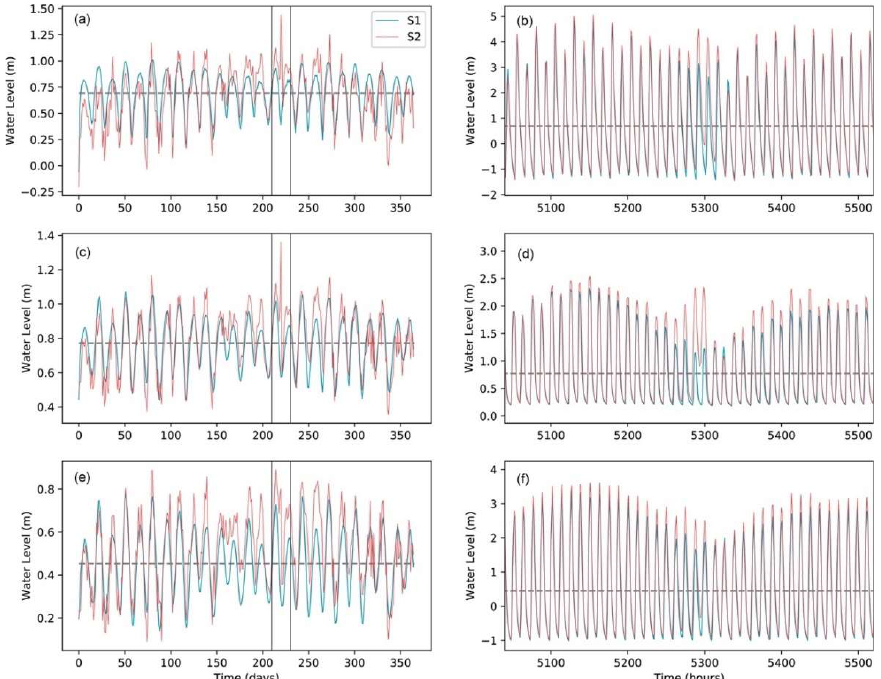
Figure 4. Sea level at the head of three estuaries downstream of the selected rivers, ( a , b ), ( c , d ), and ( e , f ), representing the series in P0, P1, and P2, representatively. ( a , c , e ) Daily mean values and ( b , d , f ) hourly values. The time window used for the hourly time series was the Typhoon Lekima period (marked with the thin, gray, dashed line in the left panels). The horizontal dashed line is the mean value for S1.